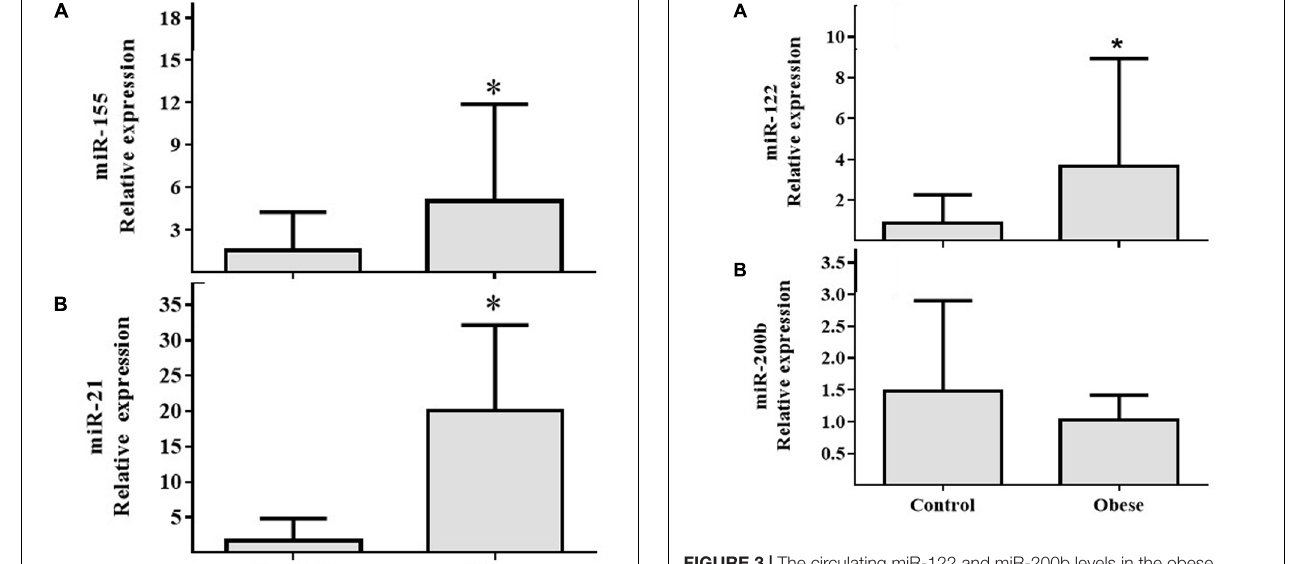
FIGURE 3 | The circulating miR-122 and miR-200b levels in the obese subjects compared with the normal weight controls. (A) Differential relative miR-122 expression levels verified by qRT-PCR in the serum samples from normal weight ( n = 17) and obese ( n = 17) subjects ( p = 0.03). (B) Differential relative miR-200b expression levels in the serum samples from normal weight ( n = 17) and obese ( n = 17) subjects ( p = NS). Values are median and range interquartile. Mann–Whitney test. ∗ Indicates significant